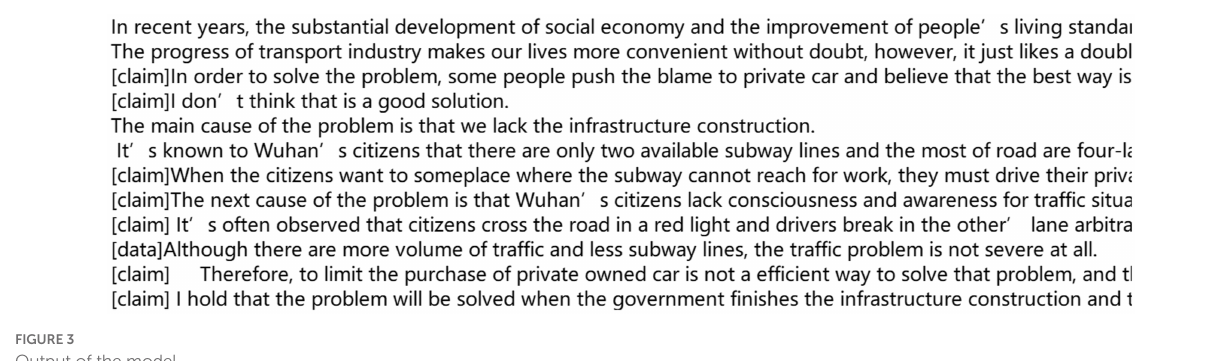
FIGURE 3 Output of the